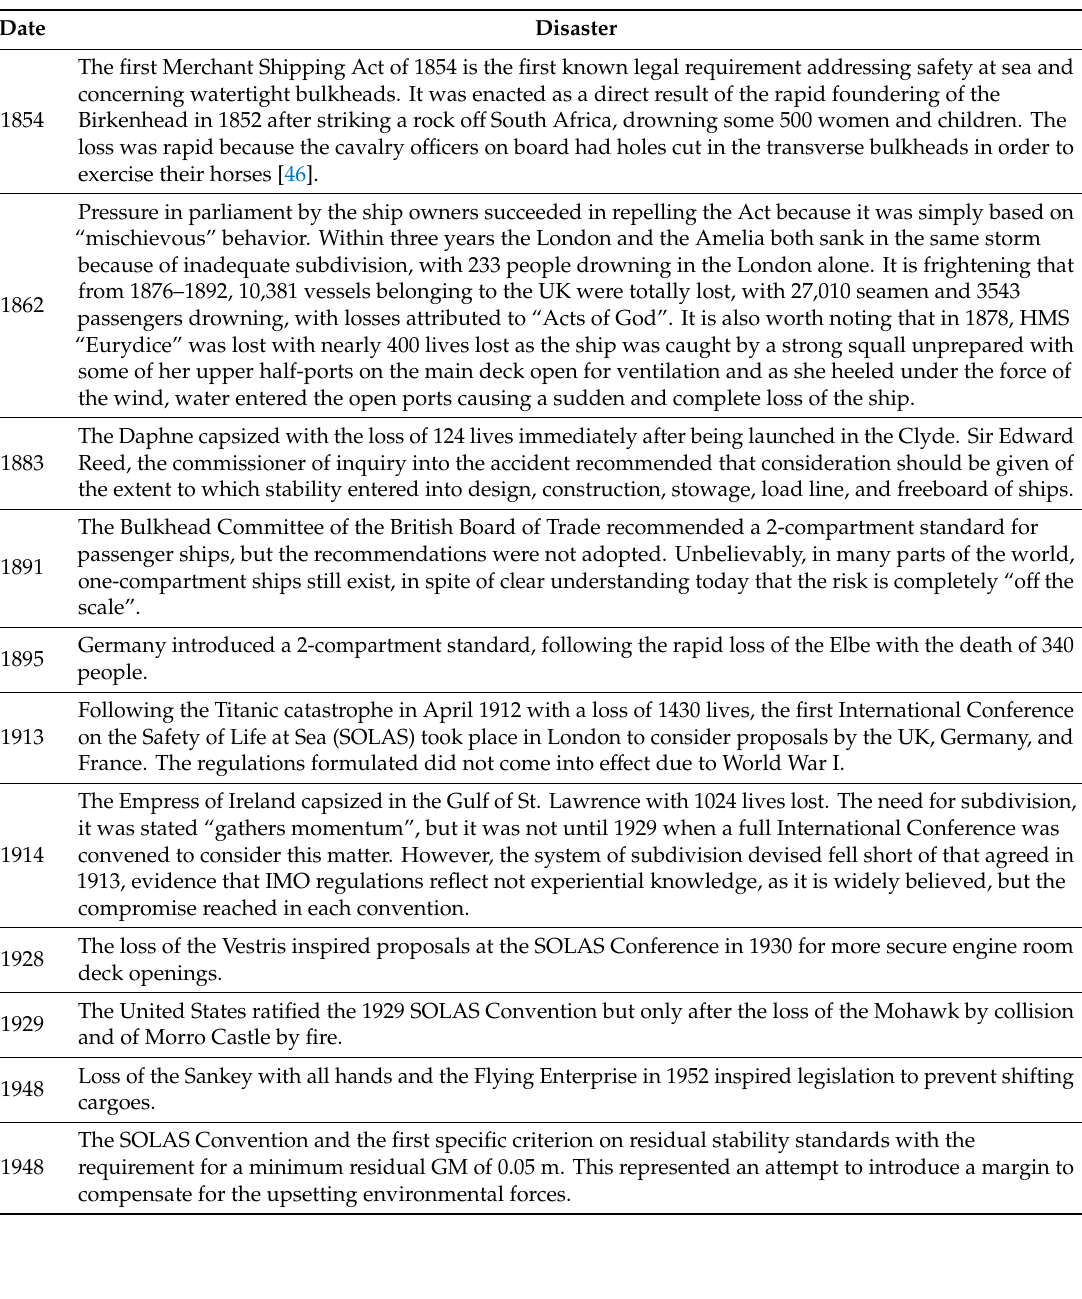
Table 1. A Record of Disasters and Related Legislation /